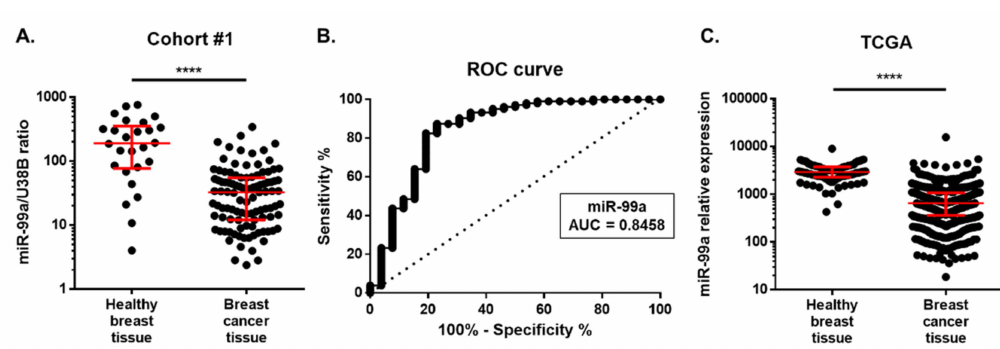
Figure 2. ( A ) MiR-99a expression levels in breast cancer tissues from Cohort #1. Di ff erential miR-99a expression levels in 103 breast cancer tissues were compared with 26 normal breast tissues. Red horizontal line: median with interquartile range. Mann–Whitney U, **** p < 0.0001. ( B ) Receiver-operating characteristic (ROC) curve analysis for miR-99a expression levels in breast cancer tissue samples. ( C ) TCGA data for the expression of miR-99a-5p in normal solid tissue ( n = 52) and breast primary tumour ( n = 782). Expression is represented as reads per million miRNA mapped. Horizontal line: median with interquartile range. Mann–Whitney U, **** p <